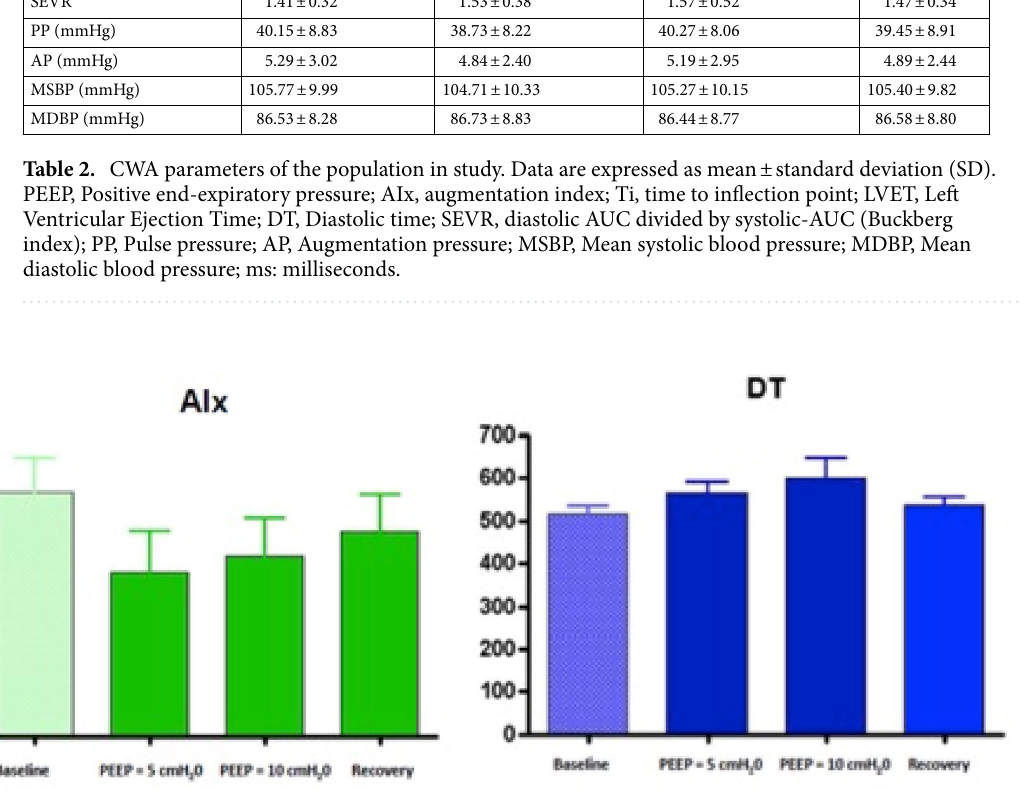
Figure 1. Clustered column for AIx (chart on the left) and DT (chart on the right) from baseline to Recovery; no significant difference observed between the measurements. Data are presented as mean, error bars represent standard deviation. CTR, percentage of changes in comparison to control; AIx, augmentation index; DT, Diastolic